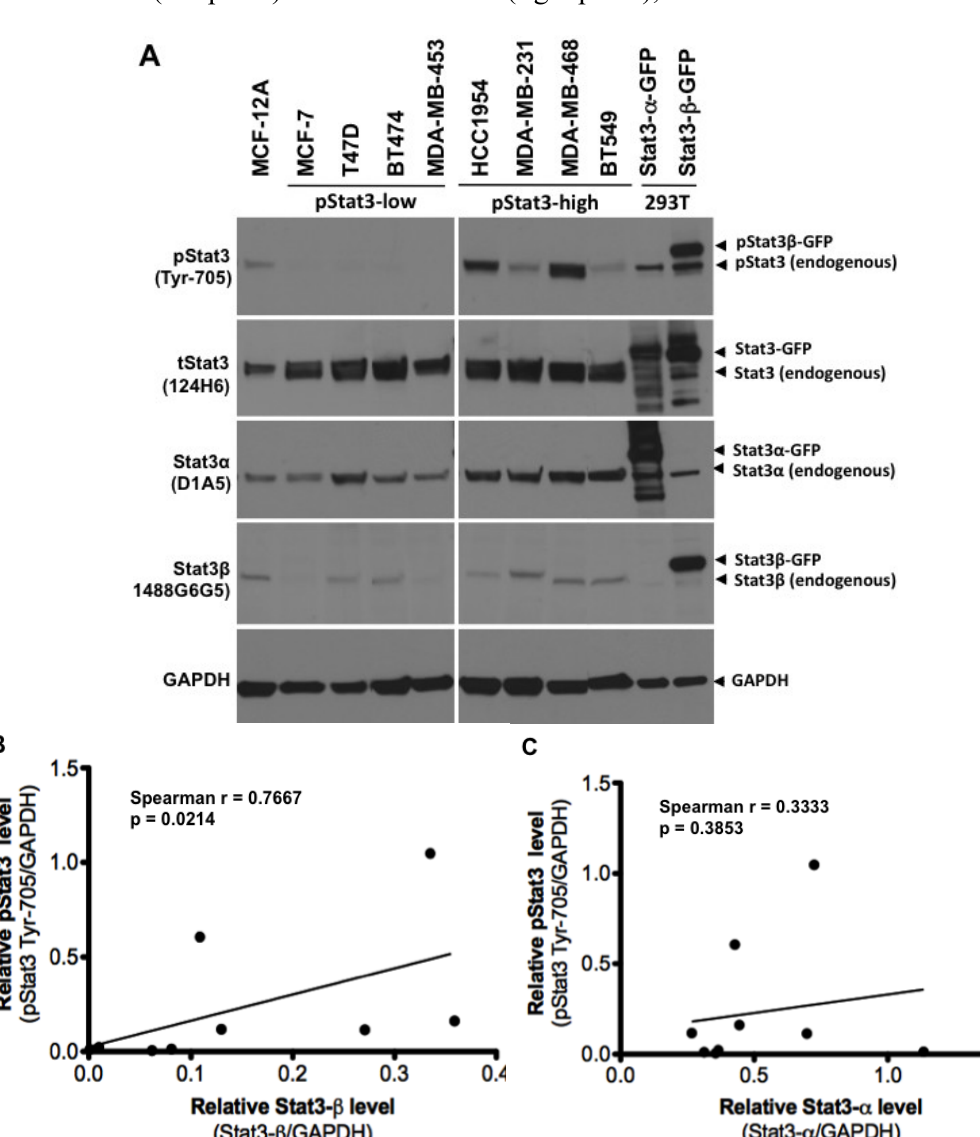
Figure 7. Stat3β overexpression correlates with Stat3 phosphorylation in breast cancer cell lines. In panel ( A ), lysates (100 µg protein) from normal breast epithelial cells MCF-12A, and breast cancer cell lines MCF-7, T47D, BT-474, MDA-MB 453, HCC1954, MDA-MB-231, MDA-MB-468, and BT549 cells were subjected to SDS-PAGE, transferred to nitrocellulose membrane and probed for total pStat3 (Tyr-705, clone D3A7), tStat3 (clone 124H6), Stat3α (clone D1A5), Stat3β (1488 G6G5) and GAPDH. Lysates (30 µg of protein) from 293T cells, mock transfected (transfection reagent alone) or transiently transfected with plasmids encoding fusion proteins Stat3α-GFP and Stat3β-GFP were used as controls (lanes 10–11). Stat3β and GAPDH levels were quantified by densitometry and the GAPDH-normalized pStat3 levels plotted as a function of their corresponding Stat3β levels ( B , Spearman r = 0.7667, p < 0.05) or Stat3α levels ( C , Spearman r = 0.3333, p > 0.05). In panel D , Stat3β-GFP was constitutively phosphorylated when overexpressed in both 293T cells (left panel) and Stat3 −/− MEFs (right panel), while Stat3α-GFP was